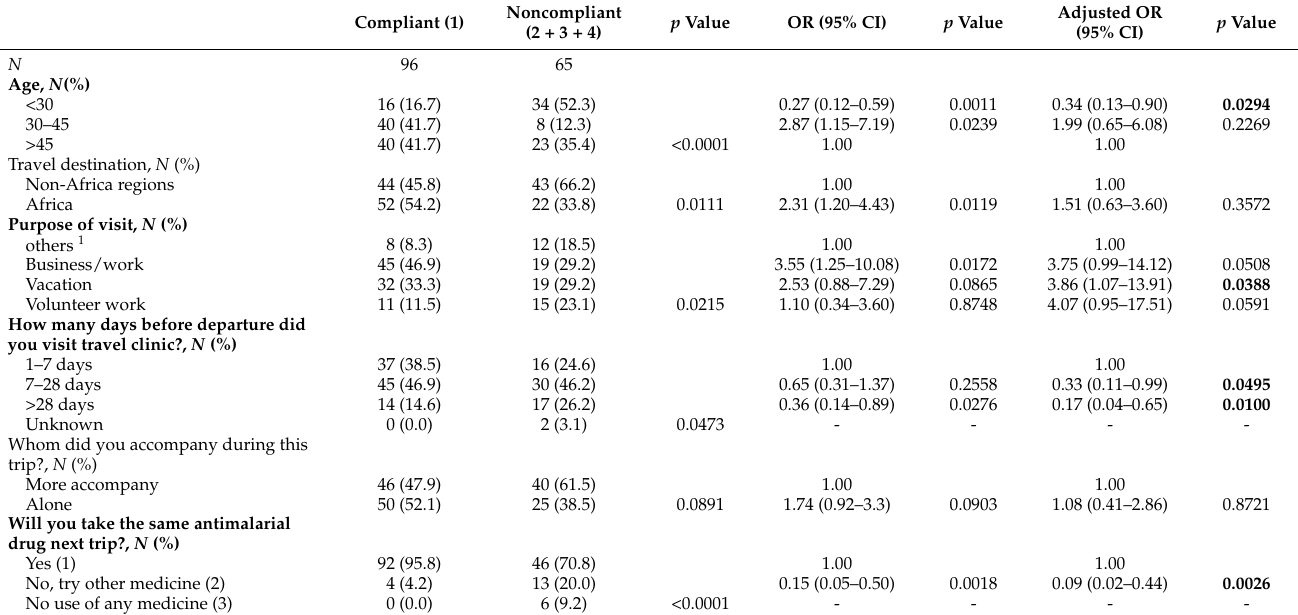
Table 4. Results of multiple logistic regression analysis. N =